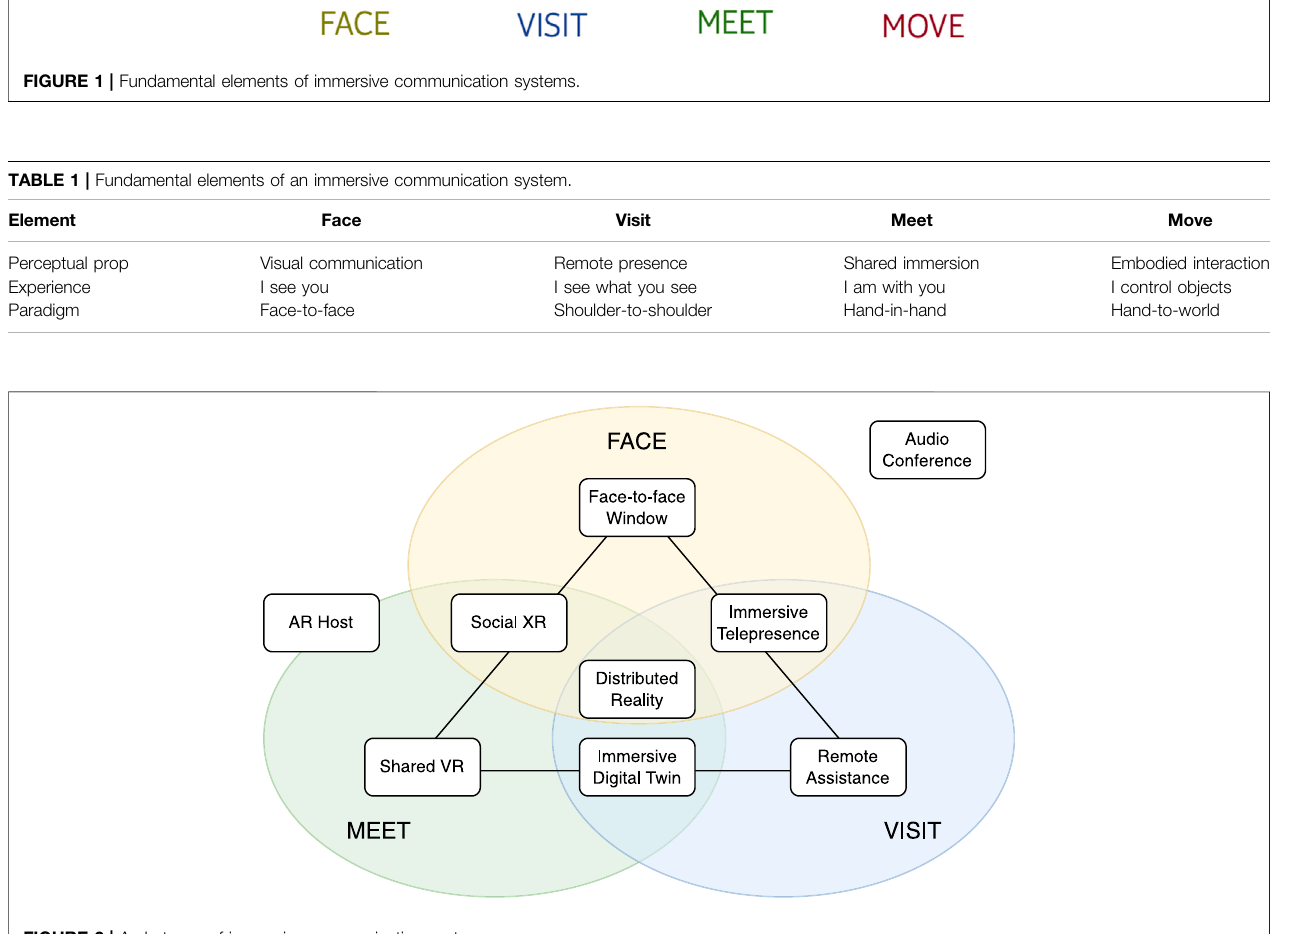
communication experience (e.g., “ I see you ” ) and paradigm (e.g., “